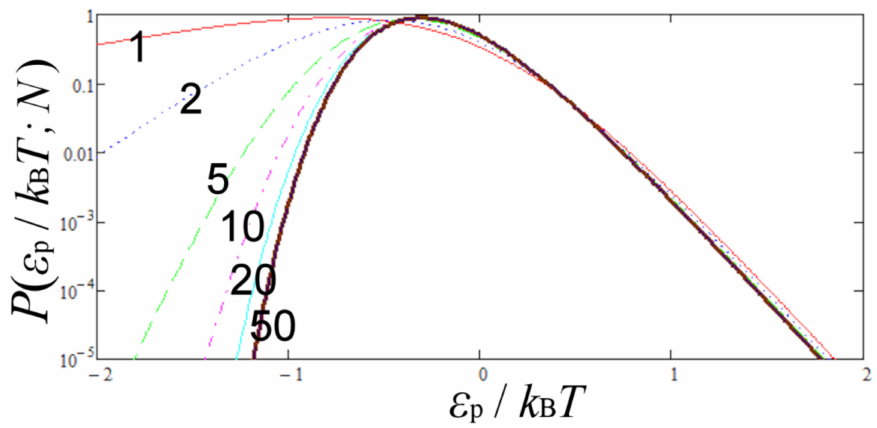
Figure 1. The kappa distribution plotted for kappa index κ 0 = 1 and various numbers of correlation particles N (1,2,5,10,20,50). As N increases, the distribution approaches its limiting case from Equation